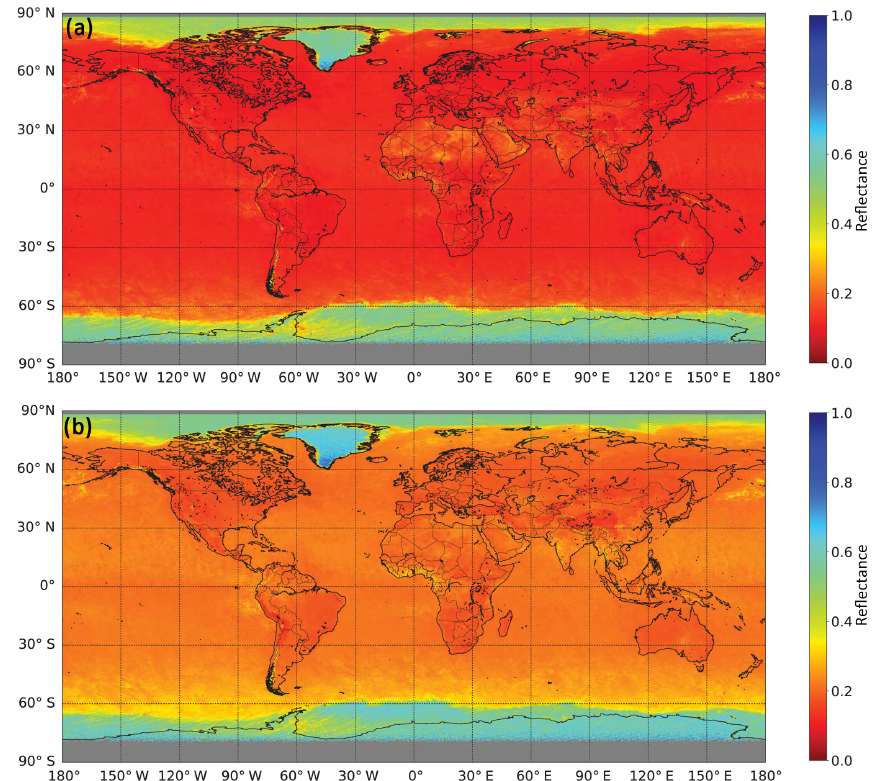
Figure 9. OCRA cloud-free background for G (a) and B (b) reflectances calculated using OMI data from the month of August for the years